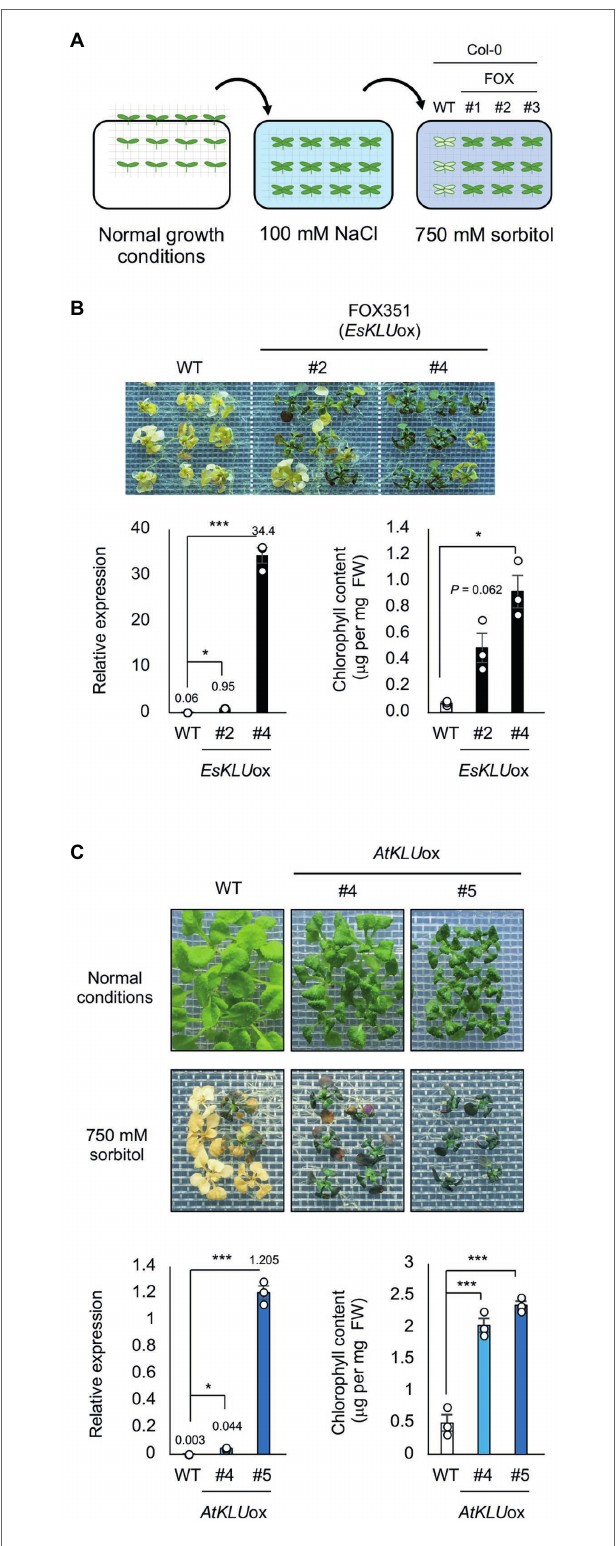
FIGURE 1 | Acquired osmotolerance of EsKLUox and AtKLU ox plants. (A) Flowchart of the acquired osmotolerance assay. Salt-acclimated 2-week- old seedlings of WT and FOX lines were mesh-transferred to Murashige and